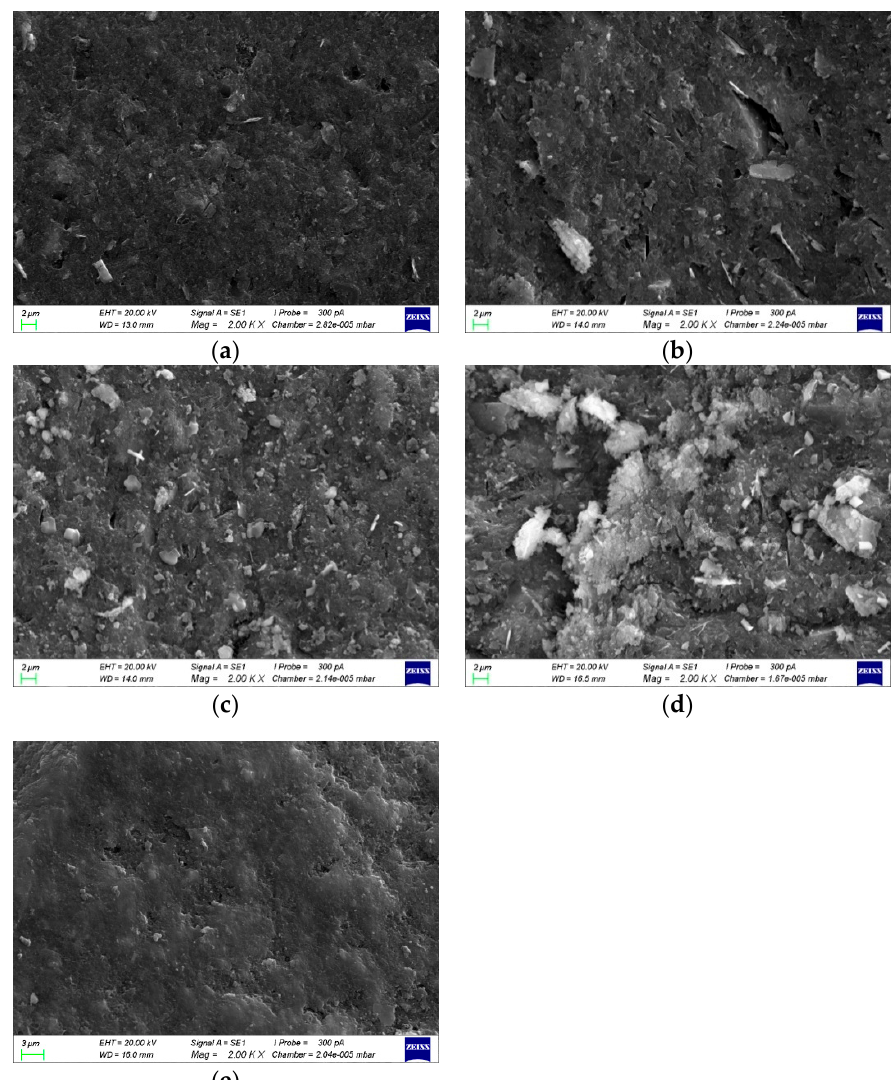
Figure 8. ( a ) The Al/Na ratio was 1.0 and the specimen was amplified 2000 times; ( b ) the Al/Na ratio was 1.1 and the specimen was amplified 2000 times; ( c ) the Al/Na ratio was 1.2 and the specimen was amplified 2000 times; ( d ) the Al/Na ratio was 1.3 and the specimen was amplified 2000 times; ( e ) the Al/Na ratio was 1.4 and the specimen was amplified 2000 times.